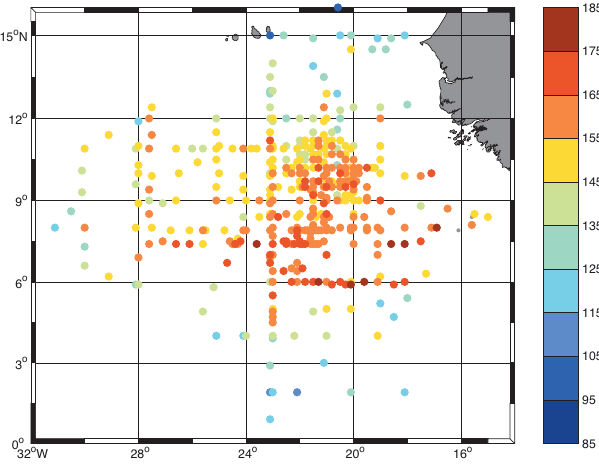
Figure 7. Mean age (yr) at σ θ = 27 . 0kgm − 3 , which corresponds approximately to the depth of the deep oxygen